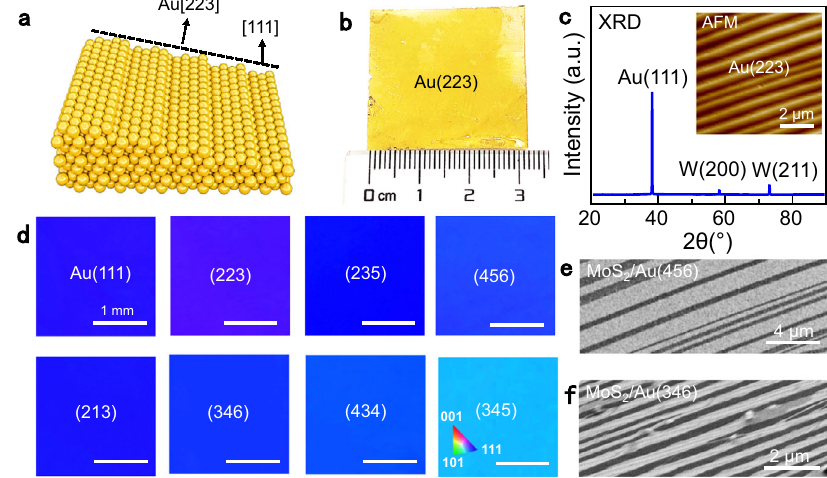
Fig. 3 Preparation of inch-scale high-miller-index Au single-crystal fi lms (Au(111) vicinal facets). a Schematic illustration of a high-index Au(223) facet. b Representative photography of the evolved Au(223) single-crystal fi lm on the W template. c . XRD pattern of Au/W foils showing the evolution of single- crystal Au(111) fi lm. Inset: AFM image of a single-crystal Au fi lm with Au(223) facet. d Representative EBSD IPF maps of the as-prepared Au fi lms, with crystal facets of (111), (223), (235), (456), (213), (346), (434), (345), respectively. The scale bars in all panels are 1 mm. e , f SEM images of the unidirectionally aligned monolayer MoS 2 ribbons evolved on single-crystal Au(456) ( e ) and Au(346) ( f ), respectively.